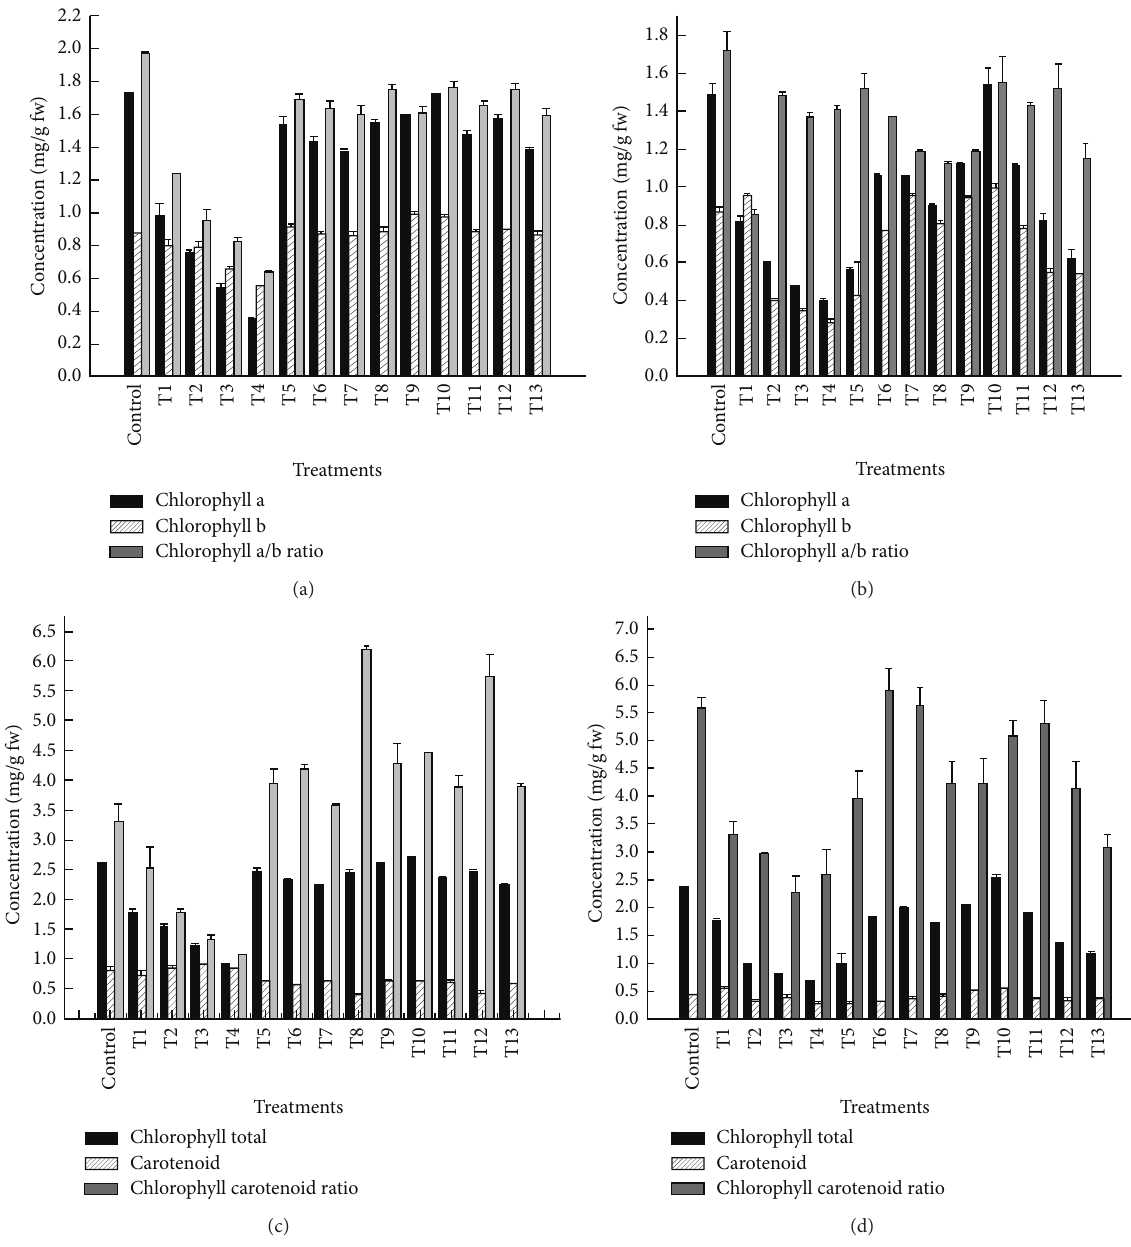
Figure 1: Effect of tannery effluent, Fe, and Zn on chlorophyll and carotenoid concentration of V. mungo after 35 and 70 days of growth.